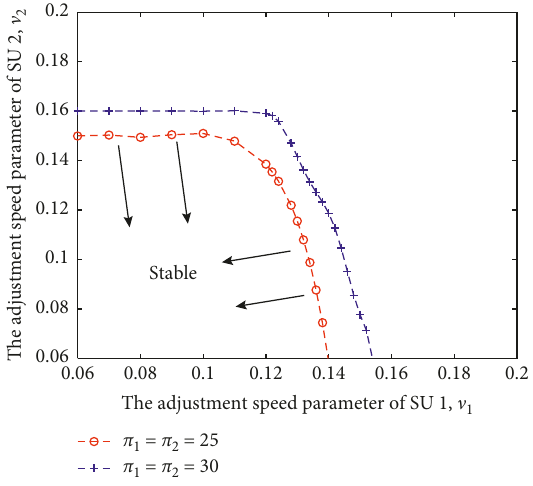
Figure 8: Stability region of dynamic